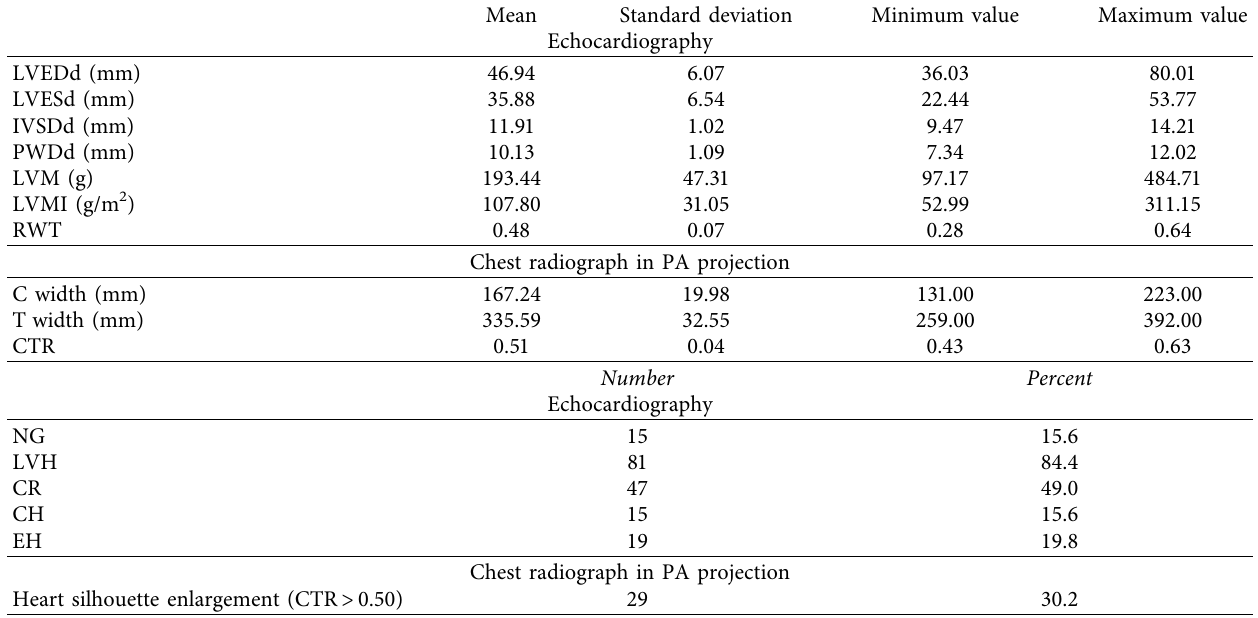
Table 2: The results of imaging studies in the study